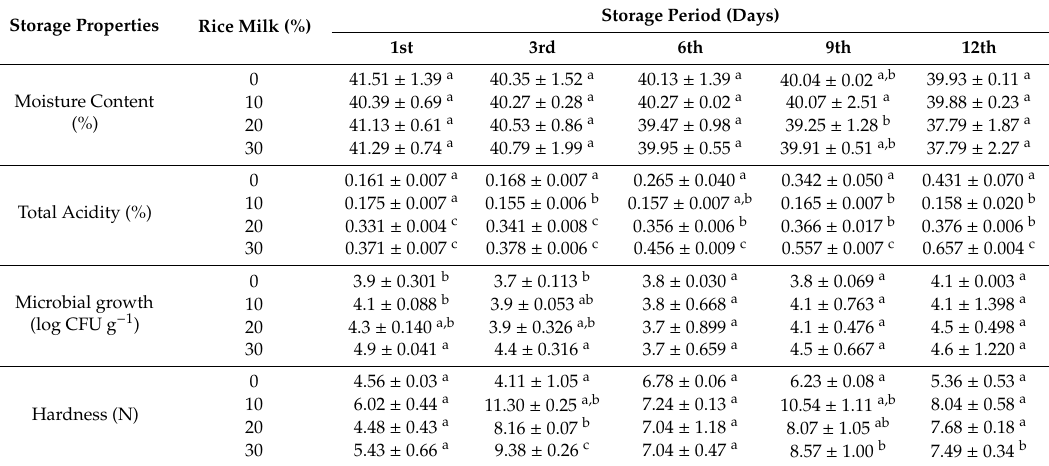
Table 2. Paneer properties changes during storage ( ± 4 ◦